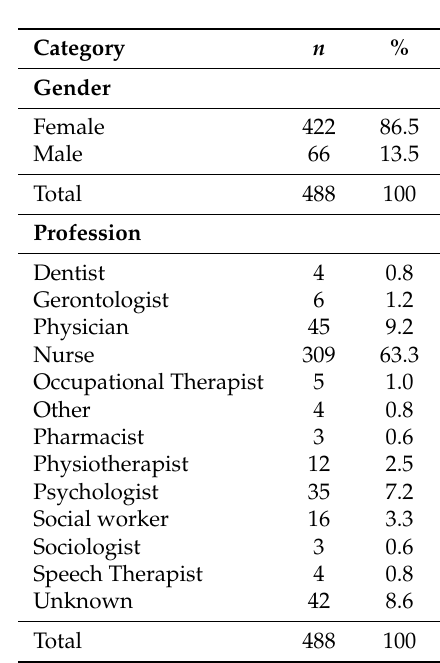
Table 3. Characteristics of